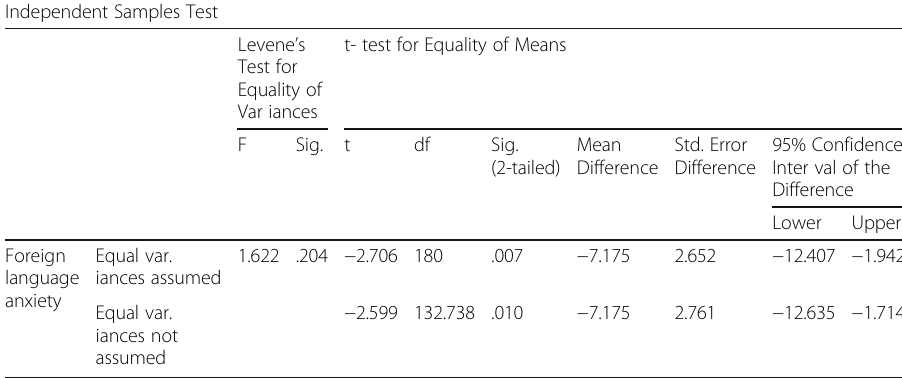
Table 5 Independent Sample T-Test between Latin and Non-Latin Language Groups Independent Samples Test